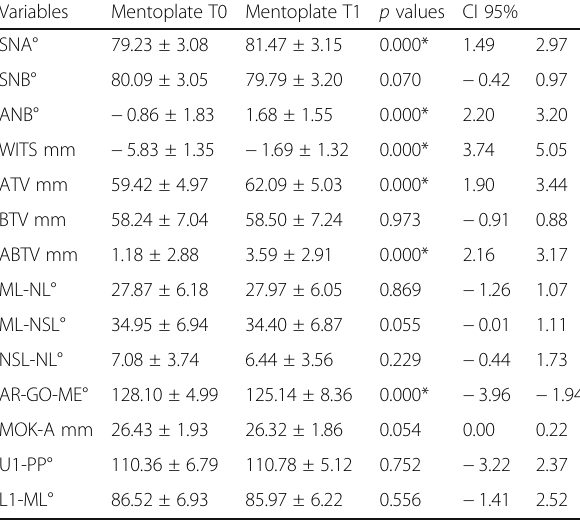
Table 6 Skeletal and dental treatment effects in the Mentoplate